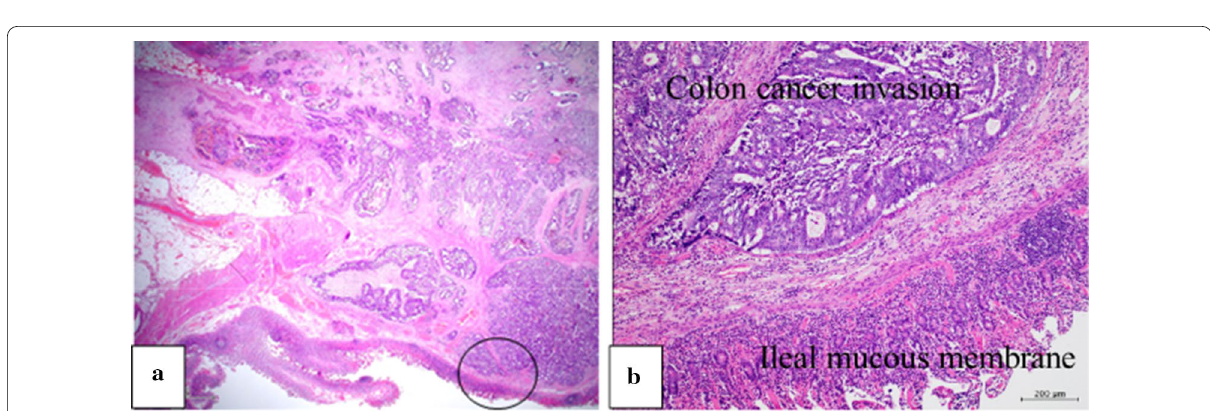
Fig. 5 a, b Histopathological analysis revealed that tumor invasion was extended to the ileal submucosa. a H&E,